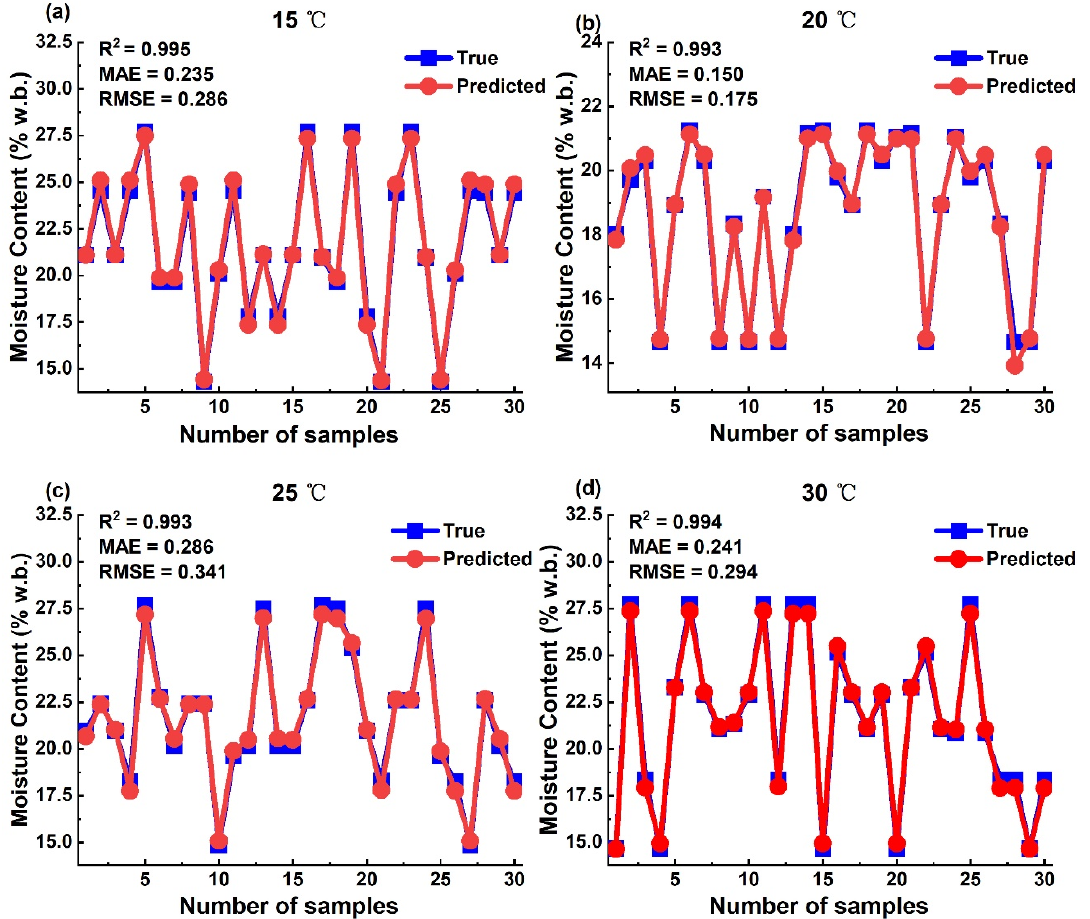
Figure 11. Performance results of different temperature test sets: ( a ) results at 15 °C ambient temperature; ( b ) results at 20 °C ambient temperature; ( c ) results at 25 °C ambient temperature; ( d ) results at 40 °C ambient temperature.